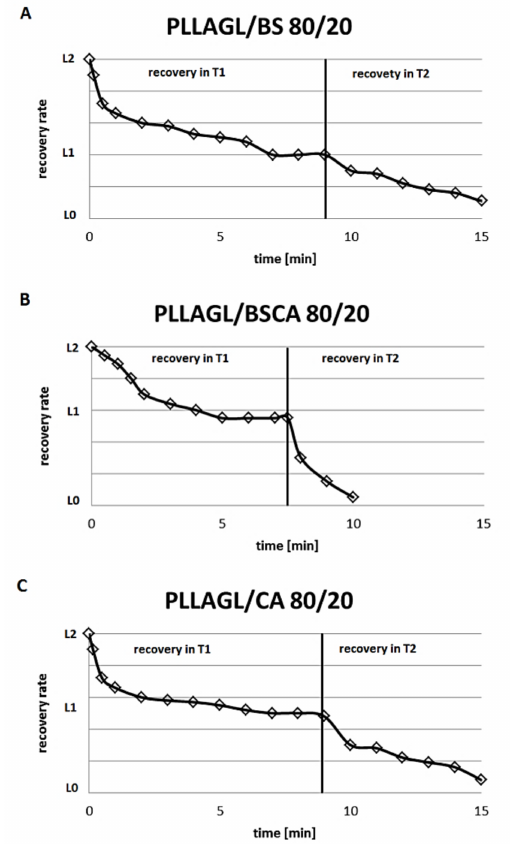
Figure 6. Dependence of the degree of return from the experiment time conducted in two di ff erent temperatures; ( A ) PLLAGL / BS 80 / 20, T1 = 46 ◦ C, T2 = 57 ◦ C, ( B ) PLLAGL / BSCA 80 / 20, T1 = 43 ◦ C, T2 = 57 ◦ C, ( C ) PLLAGL / CA 80 / 20, T1 = 48 ◦ C, T2 = 57 ◦